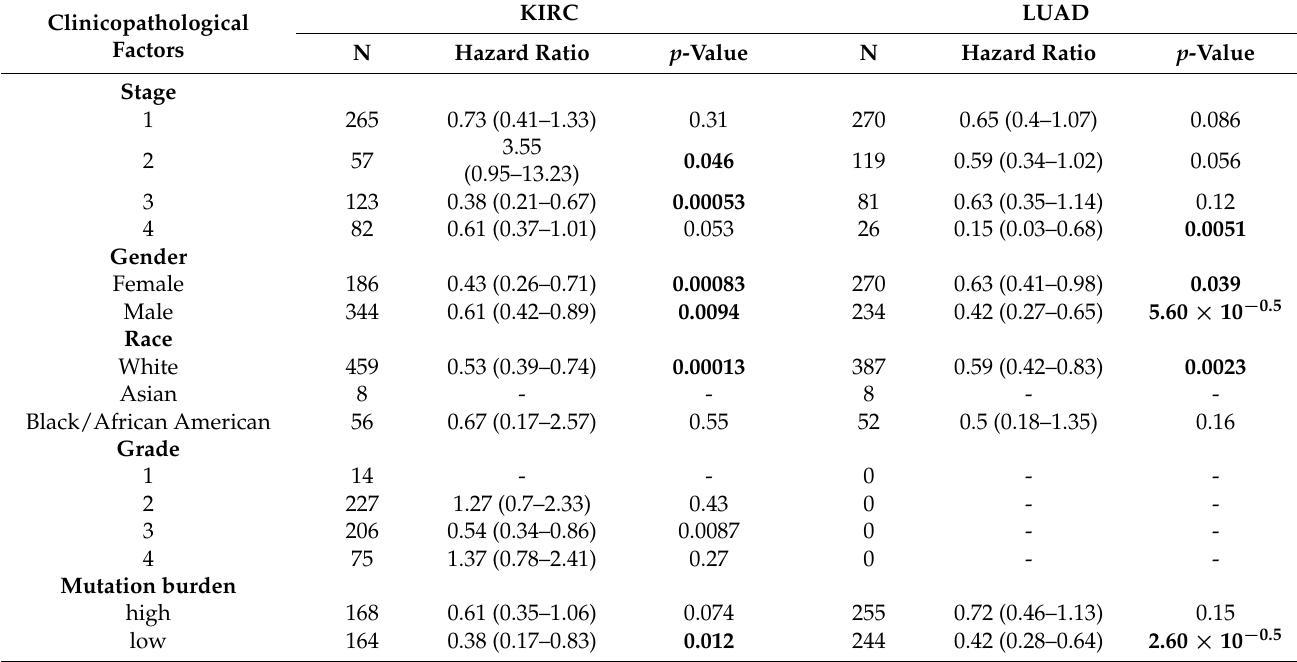
Table 1. Correlation between CRBN expression and prognosis in various clinicopathological subsets of KIRC and LUAD patients. Bold numbers indicates a statistically significant correlation with a p -value less than